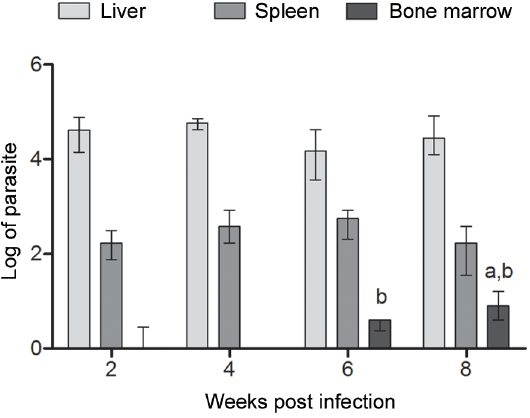
Figure 1. Parasite burden associated to the liver, spleen and bone marrow from L.infantum infected mice. Parasite burden is expressed as log 10 (number of parasites) + 1 for each individual organ (n=4, per experimental group) and represented as median 6 interquartile range of two independent experiments. Statistically significant differences were assumed when p , 0,05 in relation to (a) two weeks post-infection and (b) four weeks post-infection.